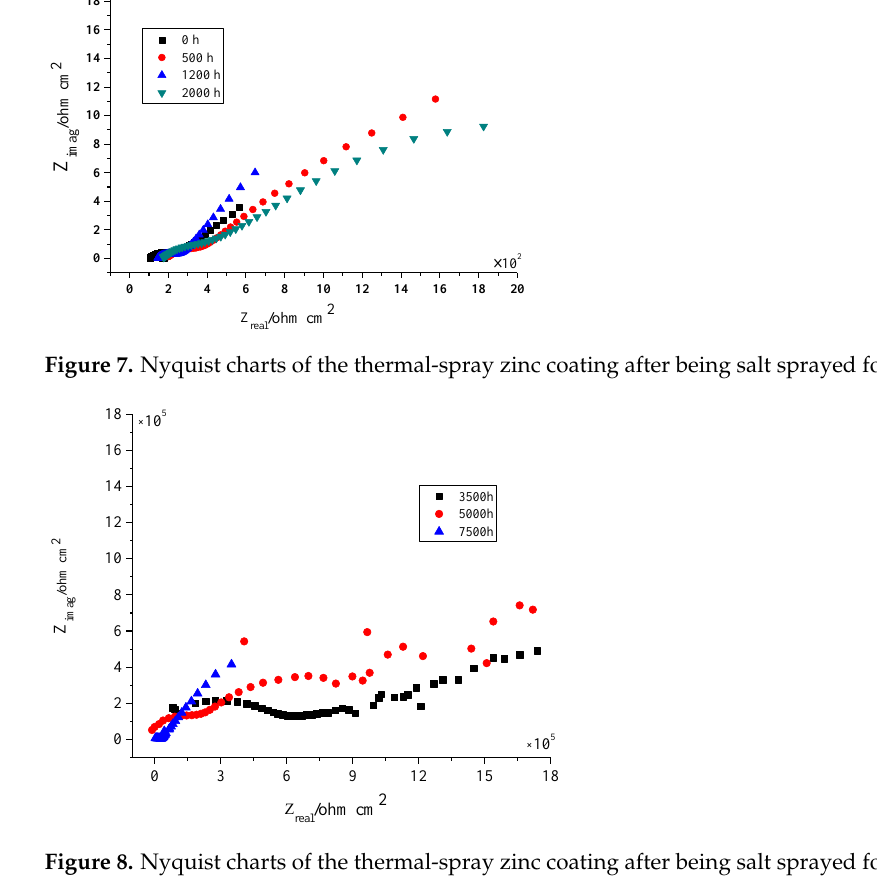
Figure 8. Nyquist charts of the thermal-spray zinc coating after being salt sprayed for 3500–7500 h.